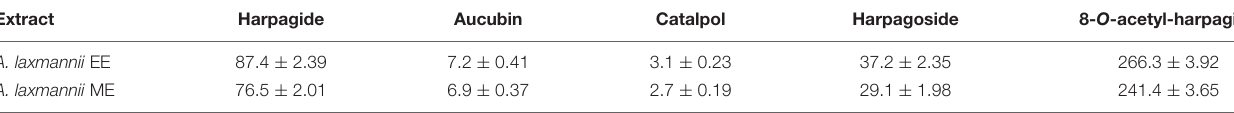
Values are the mean ± SD (n = 3).